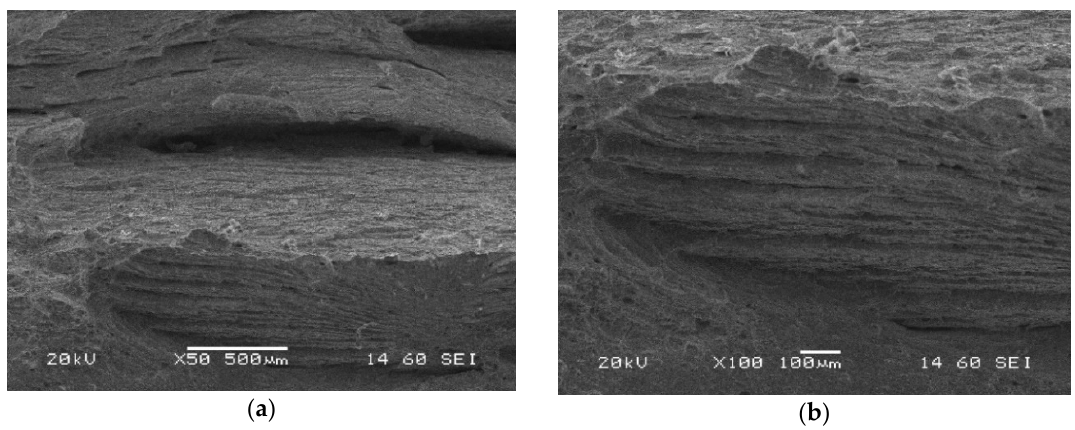
Figure 20. Microstructures of the crack propagation zone of the HAZ (specimen No. 6) captured after CTOD test using SEM; magnifications: ( a ) ×50; ( b ) ×1000.